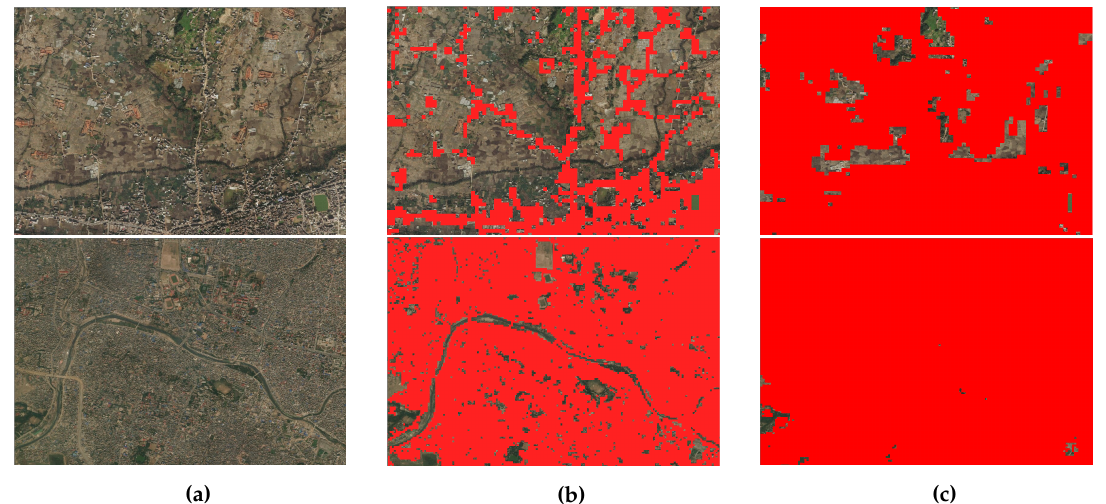
Figure 9. Comparison between the results and preexisting land cover: ( a ) latest high-resolution satellite images from Google, ( b ) the built-up area classification from the results of 2010, and ( c ) the built-up area from preexisting land covers of 2010.